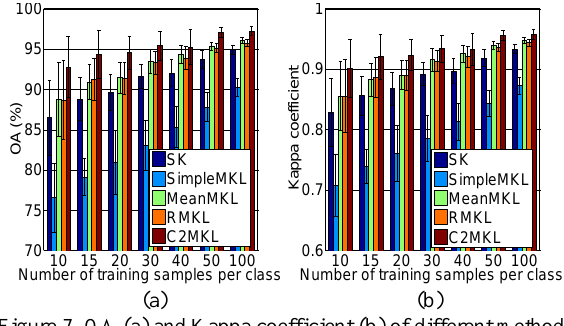
Figure 7. OA (a) and Kappa coefficient (b) of different methods on Bayview Park data set.